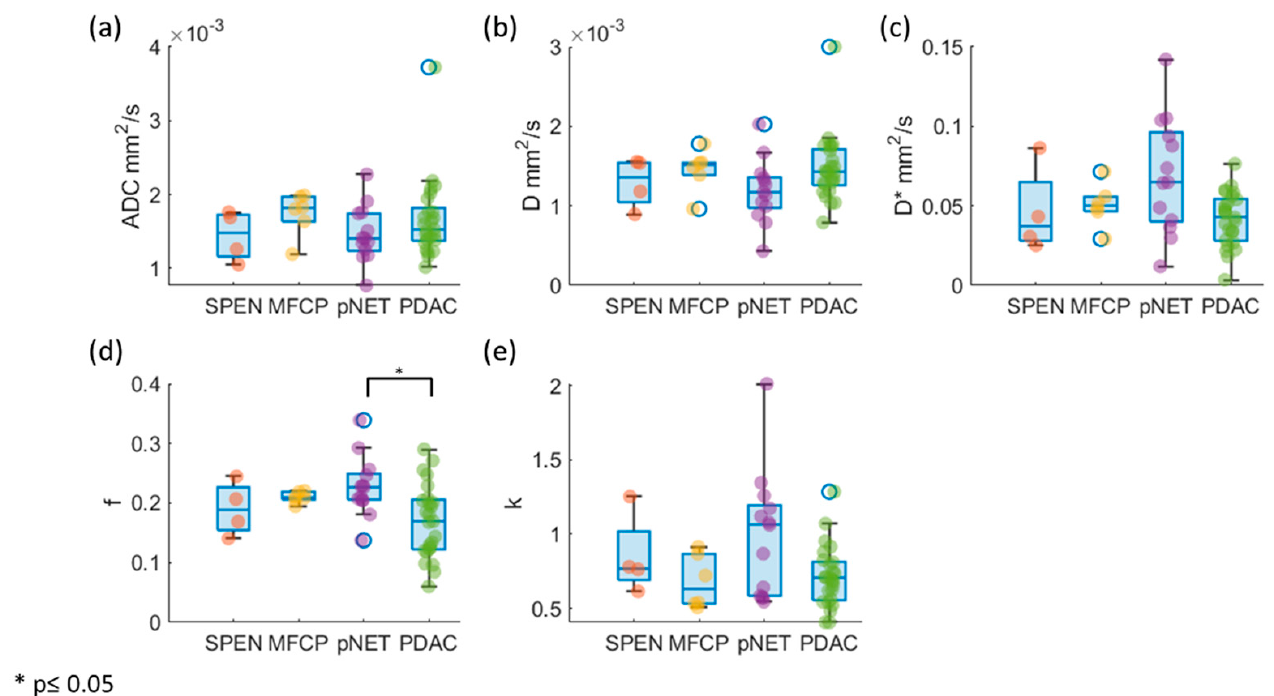
Figure 5. Box and whisker plot showing the distribution of ADC and IVIM-DKI parameters estimated using the IDTV model in PDAC, MFCP, SPEN, and pNET. ( a – c , e ) ADC, D, D*, and k showed no significant differences in pancreatic masses, and ( d ) f showed significantly higher difference in pNET compared to PDAC. Table 3. Comparison between mean of DWI and IVIM-DKI parameters quantified using new ap- proach in pancreatic masses.